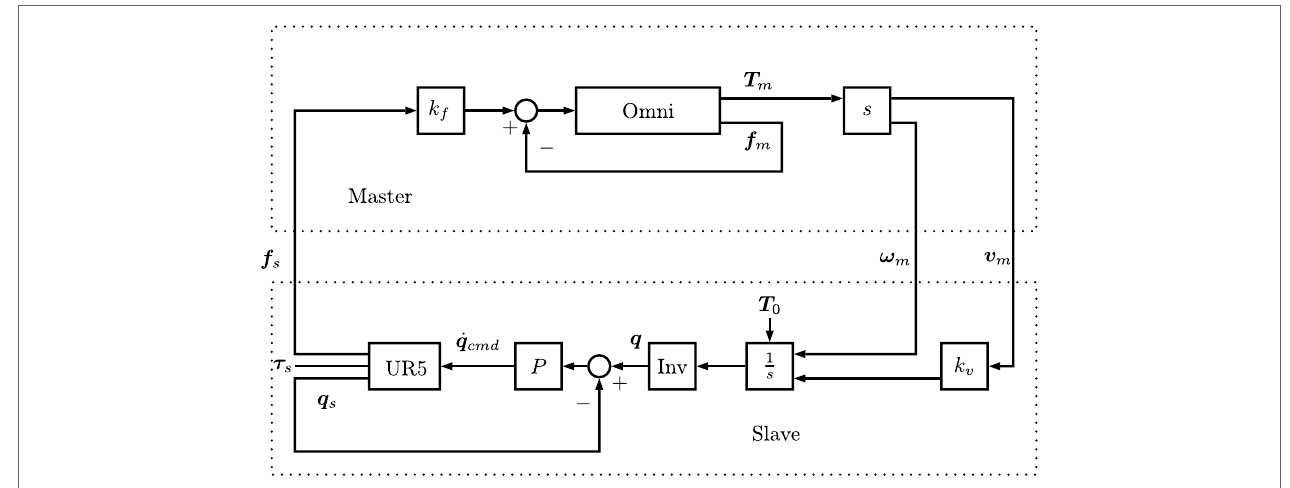
FigUre 7 | Forward flow haptic